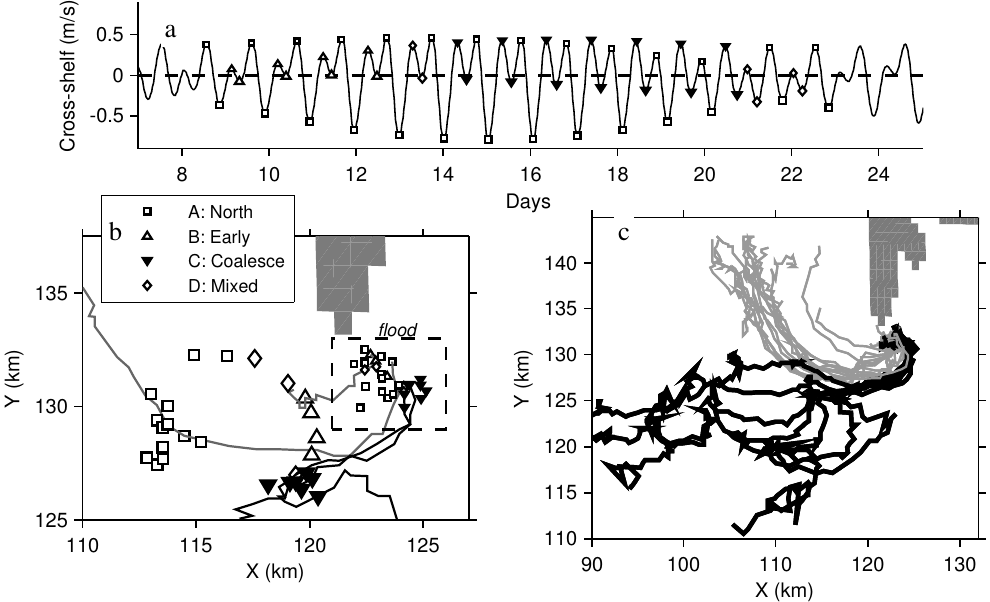
Fig. 7. Effect of advection on the fate of cape-generated vorticity. (a) The cross-shelf barotropic velocity in the vicinity of the cape. Symbols mark the times plotted in (b) . (b) Fate after half a tidal cycle of positive PV eddies generated for each flood over a spring-neap cycle. Symbols represent whether the eddies coalesced or not, with four subjective divisions indicated. Smaller symbols are the center of the eddies at the peak flood tide they are generated on; larger symbols are where they are at peak ebb half a tidal cycle later. “Coalescing” eddies tend to be formed SE of other eddies and are advected to the SW by a weak following tide. Two sample “coalescing” (black) and two “non-coalescing” tracks (grey) are also shown. (c) The tracks of all the eddies indicated in (a) and (b) : grey tracks do not coalesce, corresponding to open symbols; black tracks do coalesce and correspond to the black triangles in (a) and (b) .